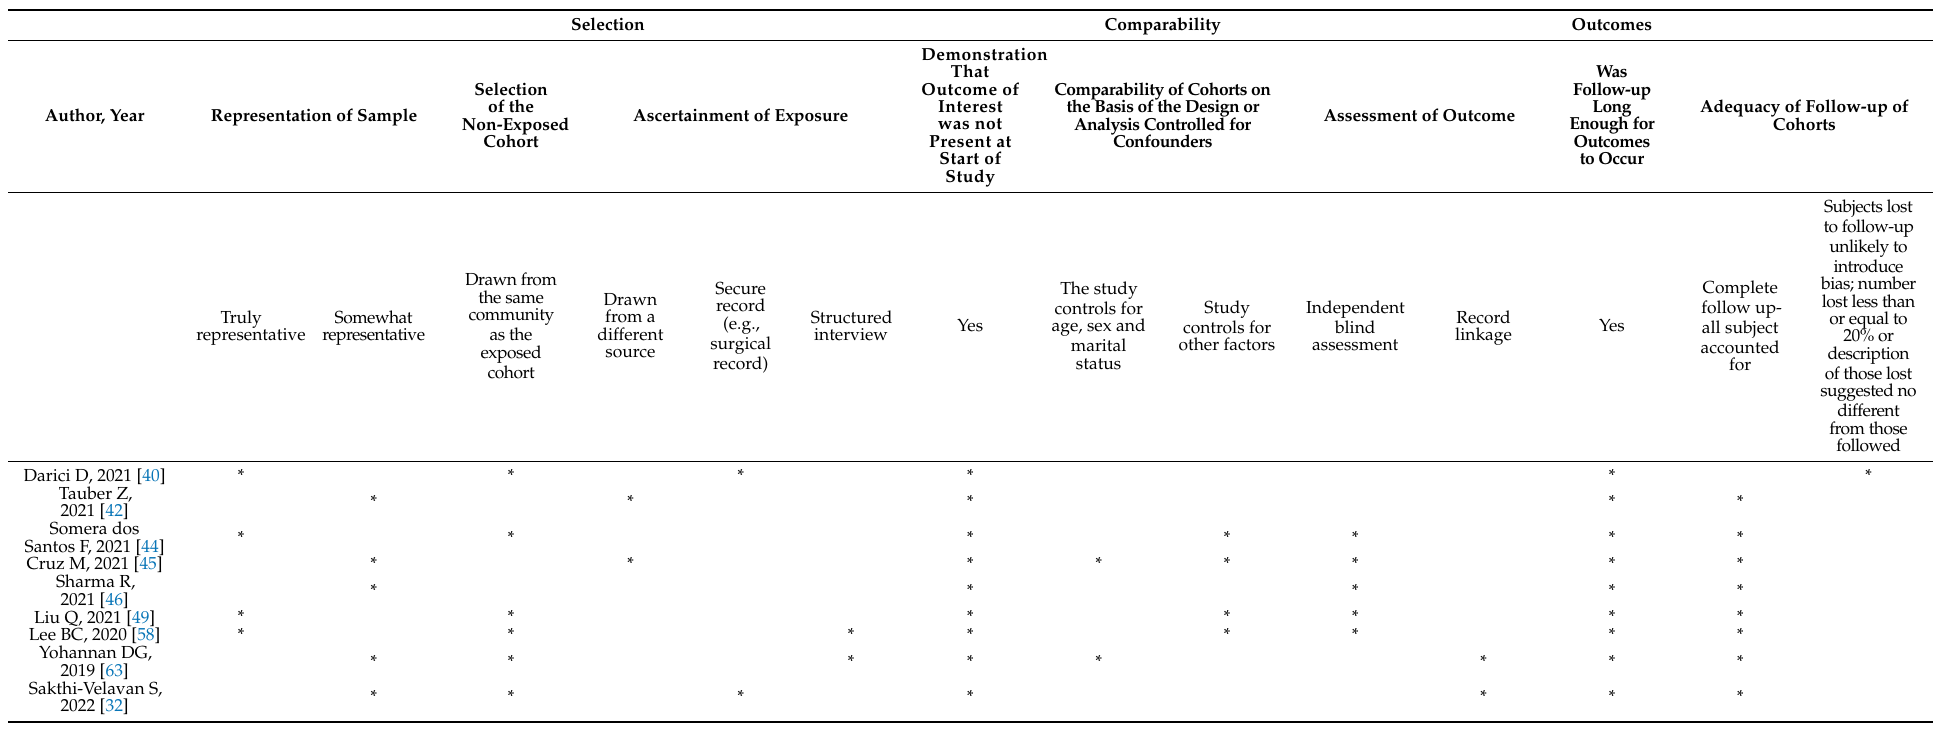
Table 2. Summary of quality assessment of cohort studies using NOS